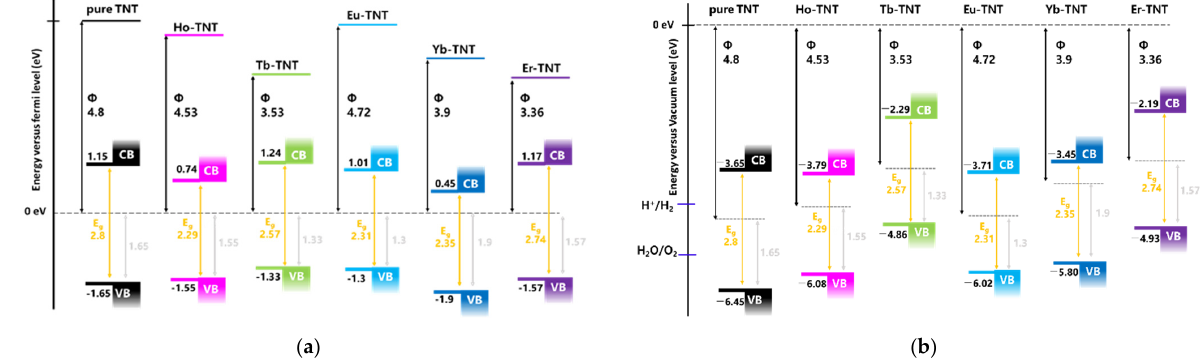
Figure 6. Energy scheme for as-prepared samples with respect to the fermi level ( a ) and vacuum level ( b ).